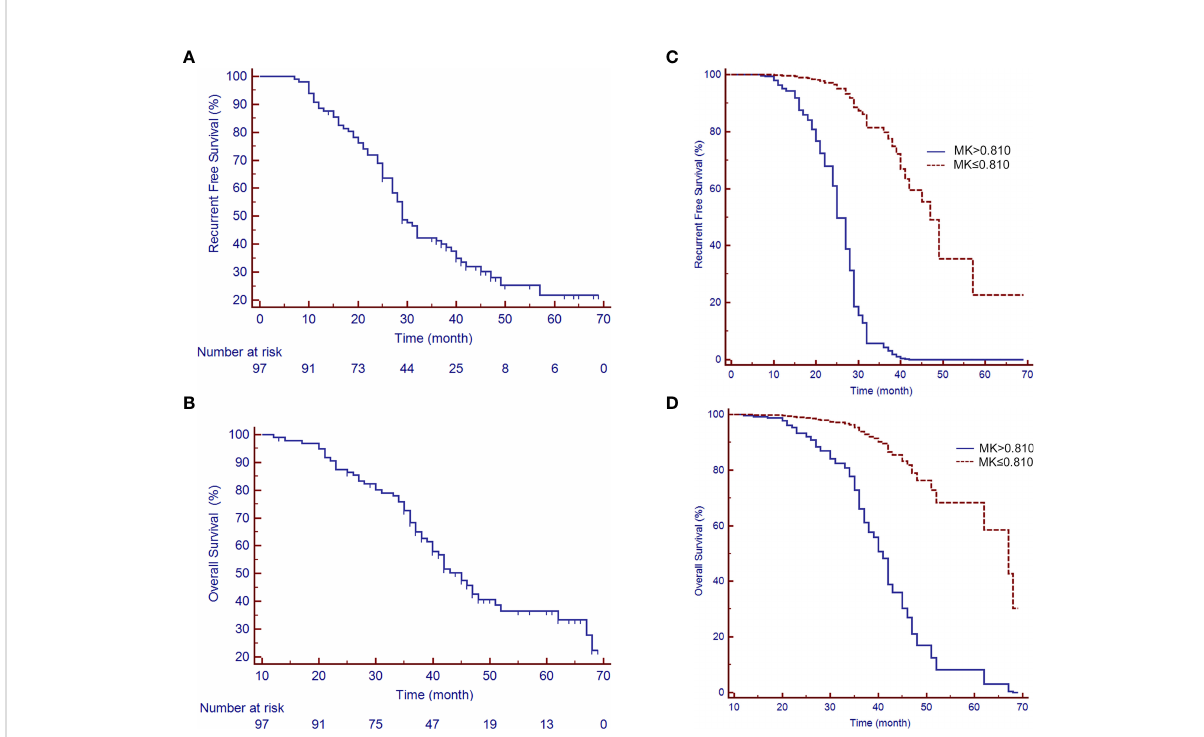
FIGURE 5 Recurrence-free survival (RFS) and overall survival (OS) rates of patients with a large HCC after liver resection (LR). (A) A median RFS period of 29 months (95% CI: 25.88-35.12) and (B) a median OS period of 45 months (95% CI: 40.50-49.50) were achieved after LR. (C, D) show the survival curves of RFS and OS, respectively, by the MK value after adjusting for potential